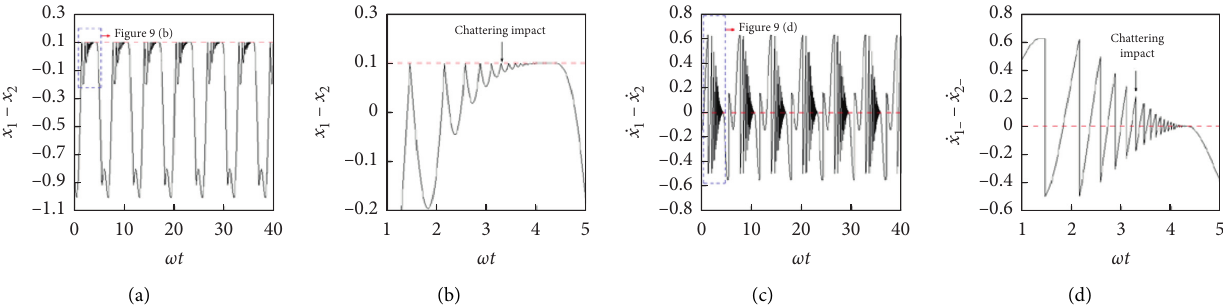
Figure 9: Time series near the sliding bifurcation point when ω � 0 . 3619. (a) Time series of x − _ x (c) time series of _ x ; (d) local enlargement of Figure 1 2